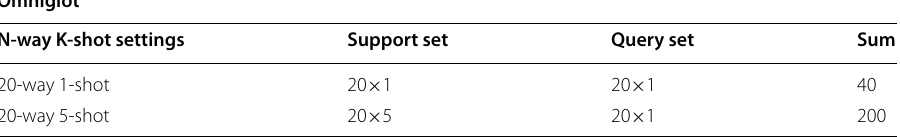
Table 2 Omniglot experiment settings Omniglot